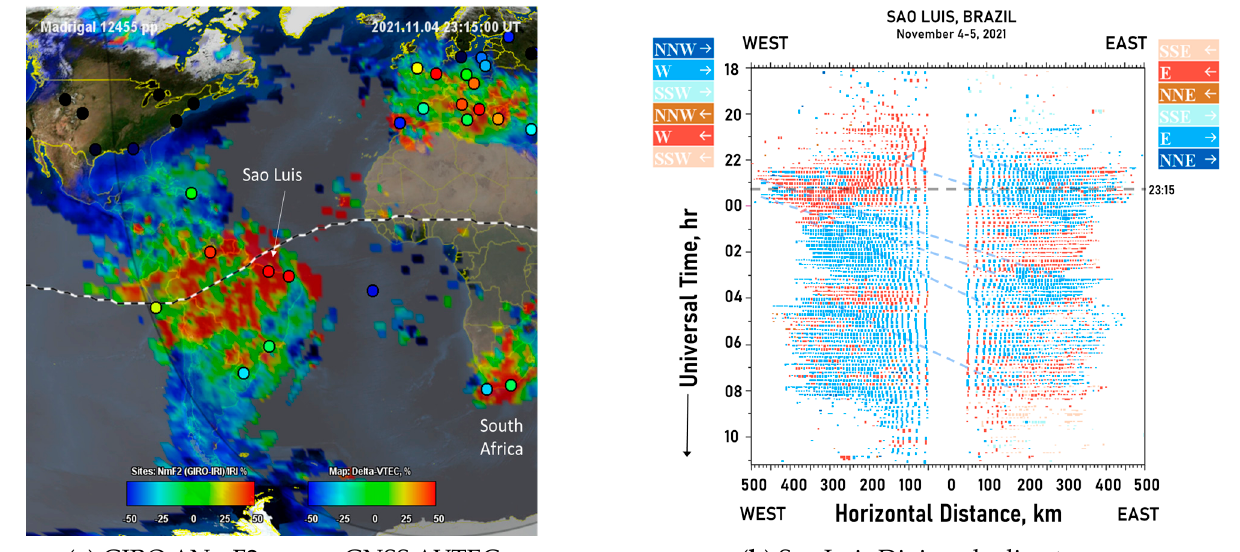
Figure 5. Low-latitude American sector anomaly during November 4, 2021, 23:15 UT. ( a ) Comparative study of the GIRO peak density ∆ N m F2 (color dots) and GNSS total content ∆ VTEC (color surface) against the 30 October 2021, quiet-time reference. The dashed line is the magnetic equator. ( b ) Sao Luis Digisonde directogram showing an intense equatorial spread F event in progress. Dashed lines: ionization bubbles drifting across the station eastward (blue color) and westward (red color).